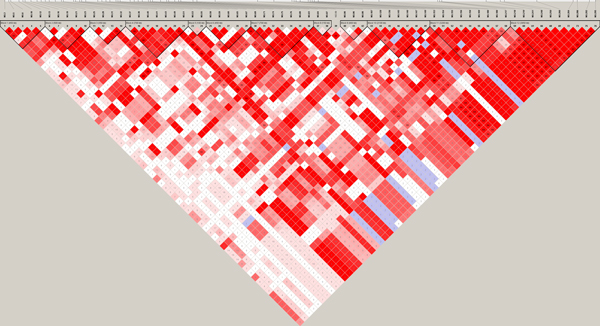
Linkage disequilibrium (LD) patterns for significant SNPs on chromosome 1 (a), 2 (b) and 3 (c). Values in boxes are D' values between SNP pairs and the boxes are coloured according to the standard Haploview colour scheme: LOD>2 and D'=1, red; LOD>2 and D'<1, shades of pink/red; LOD<2 and D'=1, blue; LOD<2 and D'<1, white (LOD is the log of the likelihood odds ratio, a measure of confidence in the value of D'). LD blocks are marked with triangles.